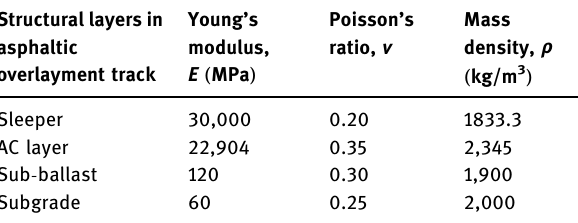
Table 3: Material properties of asphaltic overlayment track Structural layers in asphaltic overlayment track